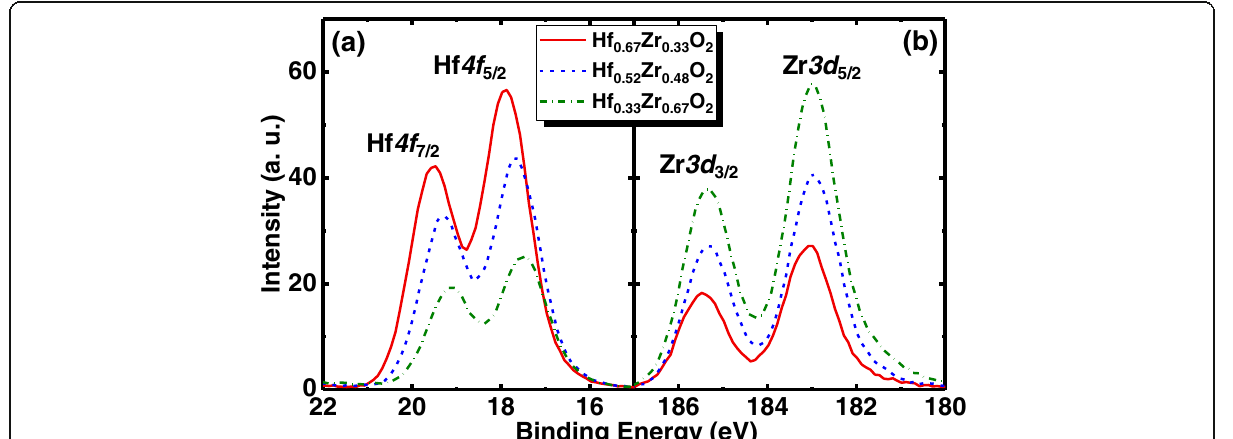
Fig. 2 ( a ) Hf 4f and ( b ) Zr 3d core level spectra for the Hf 1 − x Zr x O 2 samples with the different Zr